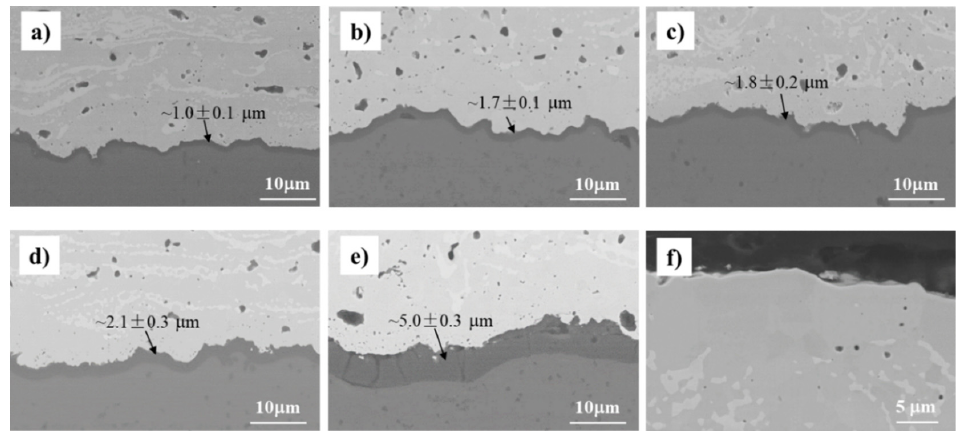
Figure 9. Microstructures of LPPS EBCs for various steam cycles. ( a ) 200 cycles; ( b ) 400 cycles; ( c ) 600 cycles; ( d ) 800 cycles; ( e ) 1000 cycles; ( f ) Top coat cross-section microstructure after 1000 cycles at 1316 °C in 90% H 2 O (g) + 10% air. For LPPS EBCs, a thin and dense SiO 2 TGO layer is observed for all samples at vari- ous numbers of cycles (Figure 9). The average TGO thickness is ≈ 1.0 µm (against ≈ 20 µm for APS EBC) after 200 cycles, and it gradually grows to ≈ 2.1 µm after 800 cycles and then